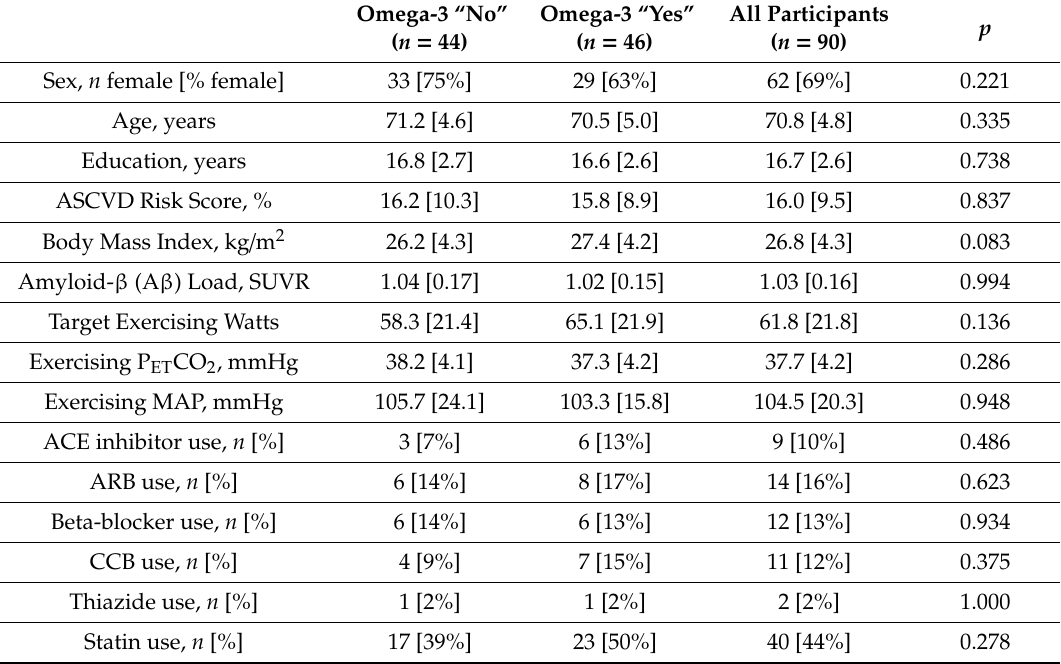
Table 1. Demographics, physiological measurements, and medication